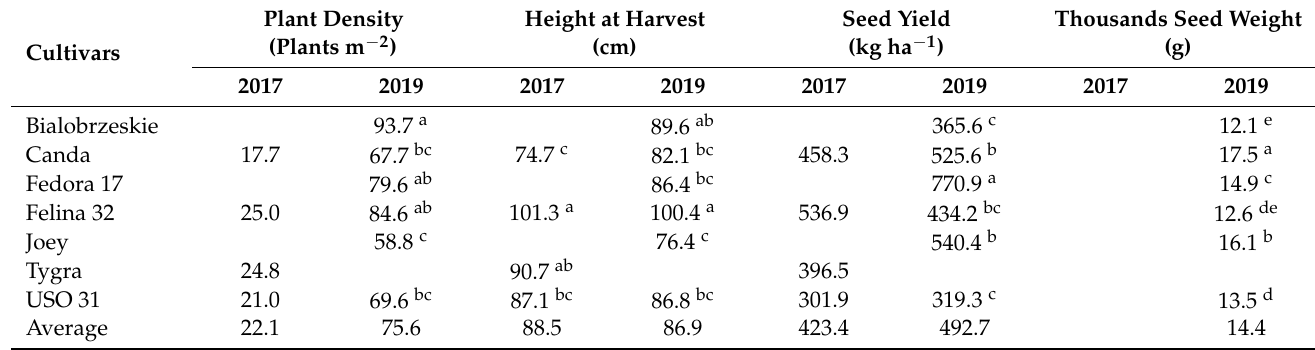
Table 3. Comparison of some characteristics of grain hemp cultivars. Values are calculated means of different planting dates.